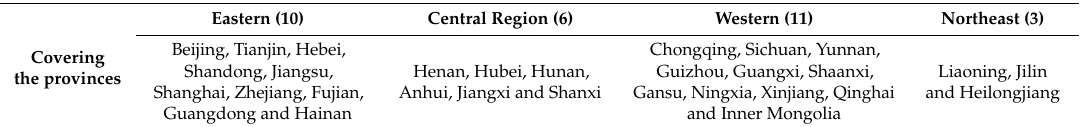
Table 8. China regional division standard.